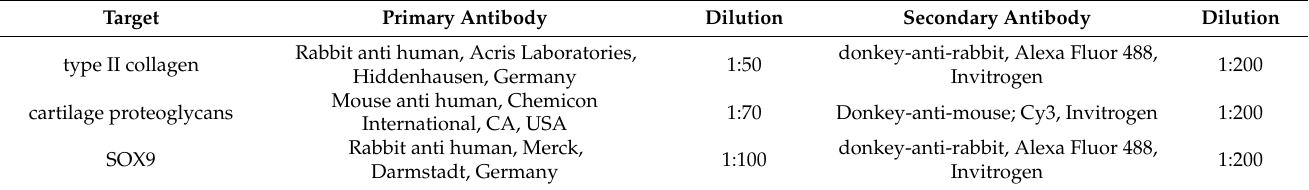
Table 2. Antibodies used in this